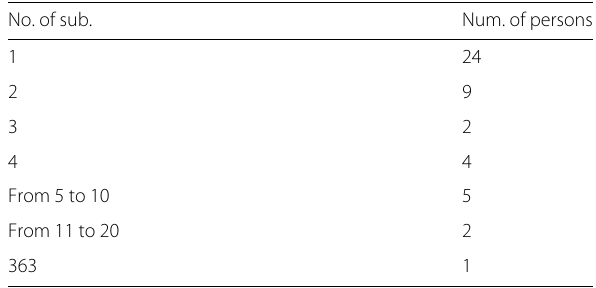
Table 1 Number of persons who made various numbers of submissions